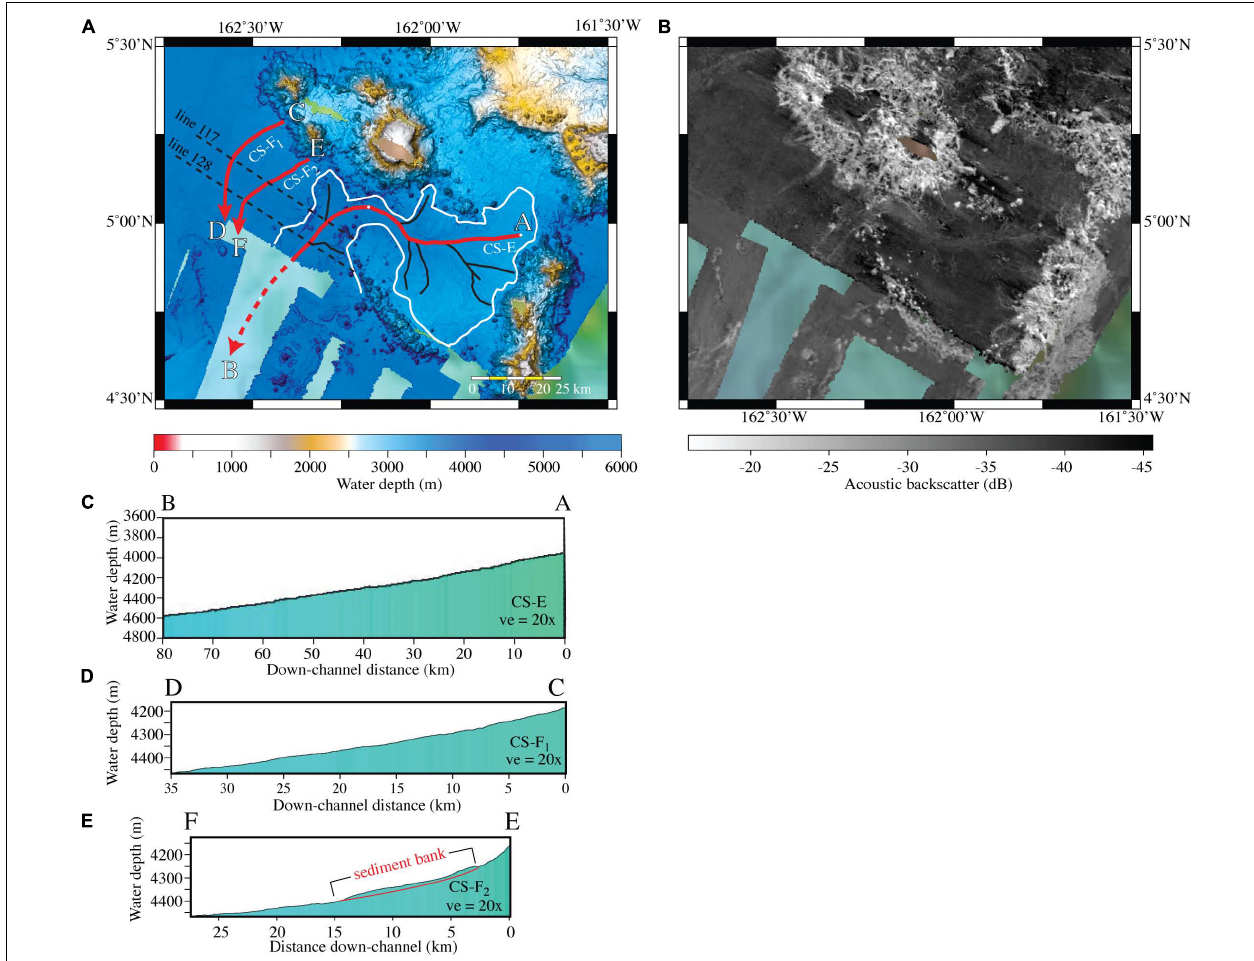
FIGURE 12 | Map view of multibeam bathymetry (A) and acoustic backscatter (B) of channel systems CS-E and CS-F (see Supplementary Figure S10 for same view with no interpretations). Locations of CS-E and CS-F shown on Figure 3 . Drainage areas (see text) of channel systems outlined in solid white line. The main channels of CS-E and CS-F are traced in bold red lines. CS-E has white 50-km distance markers. Tributaries are traced in black. Dashed bold red line is approximate southwest location CS-E main channel based on GMRT bathymetry. Dashed black lines are locations of subbottom seismic lines (see Figure 13 ) that cross CS-E and CS-F. (C) Down-channel profile of CS-E main channel showing the constant gradient of 0.4 ◦ to 0.5 ◦ . (D) Down-channel profile of CS-F 1 and (E) down-channel profile of CS-F 2 . Note sediment bank in CS-F 2